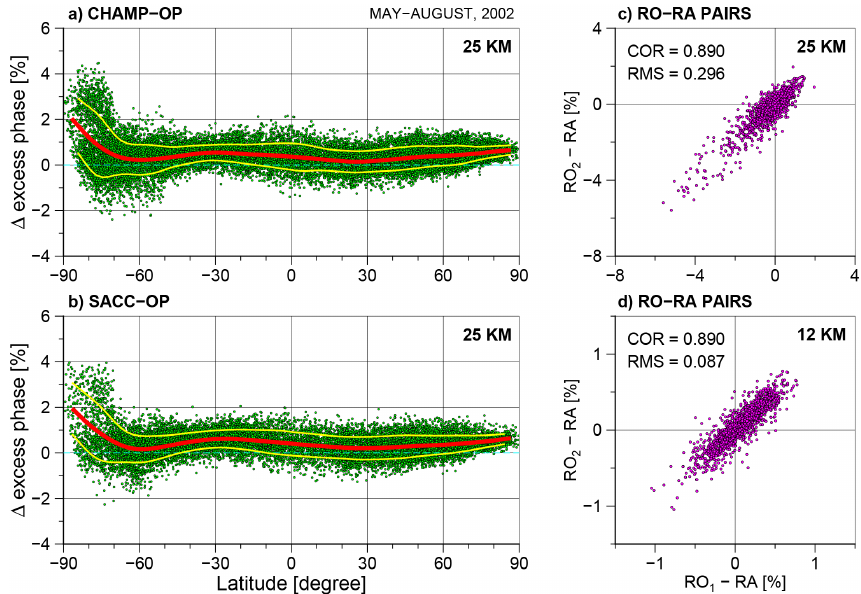
Figure 3. (a) and (b) are the same as in Fig. 1c and d, except for the separation of RO missions: (a) CHAMP and (b) SAC-C. Note that O–M is shown here, in contrast to the M–O shown in Fig. 1. This is following the convention that the data shared in the comparison are always taken as the reference. Scatter plots show RO data versus collocated RO data in terms of their deviation from ERA40 analysis over the Southern Hemisphere at (c) 25km and (d) 12km. The criteria for the collocation are less than 2h in time and closer than 300km in the great circle distance. Note that the scatters are mirror symmetric with respect to y = x as result of swapping the values of x and y in each pair. The correlation coefficient and perpendicular root-mean-square distance from y = x are denoted as COR and RMS,